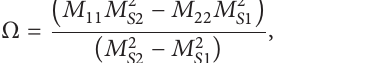
the even-mode resonant frequency varies with the parameter 𝐿 𝐿 8 . We change 8 from 5.6 mm to 7.1 mm, the even-mode is shifted from a lower to a higher frequency, while the odd- mode is not changed. Furthermore, Figures 3(a) and 3(b) show the current distribution of the two modes, respectively. There is a voltage null along the middle of the TSSLR under the odd-mode operation. In this case, the loaded element has no effect on the odd-mode characteristic, which is the reason why the parameter 𝐿 8 cannot shift the odd-mode. Under the even-mode operation, a virtual open circuit occurs along the axis of symmetry, so almost all of the current is concentrated on the proposed stub. Hence, the characteristic impedance of the proposed TSSLRs can accurately control both the odd- and even-mode resonant frequencies.